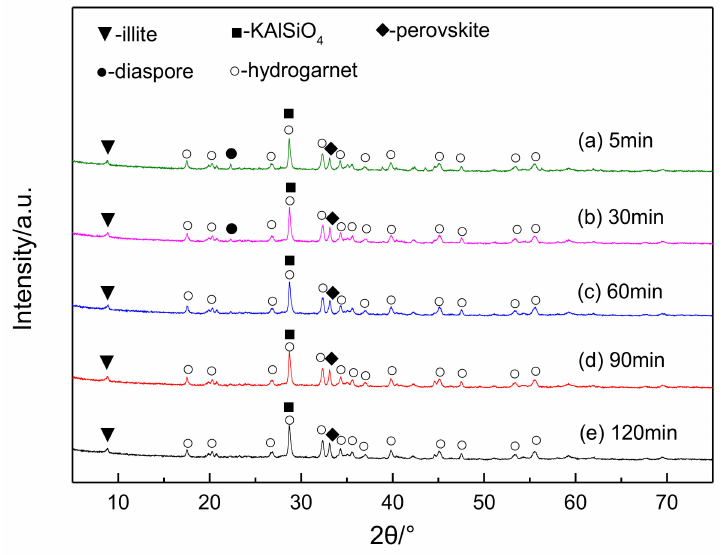
Figure 9. XRD patterns of red mud with different digestion times (conditions: ρ (K 2 O) = 254 g/L, mass ratio of CaO/ore = 8%, T = 265 ◦ C).